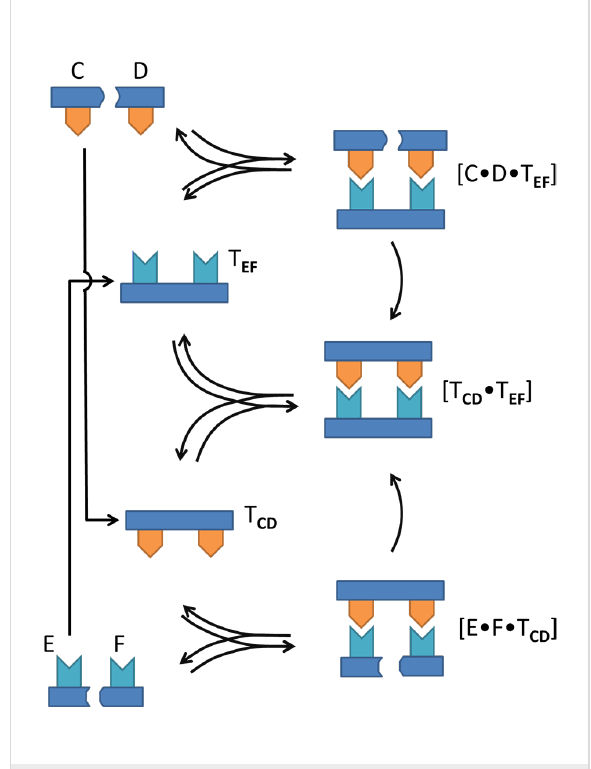
Figure 3: A cross-catalytic replication scheme in which the formation of one template stimulates the formation of a different, complementary template.